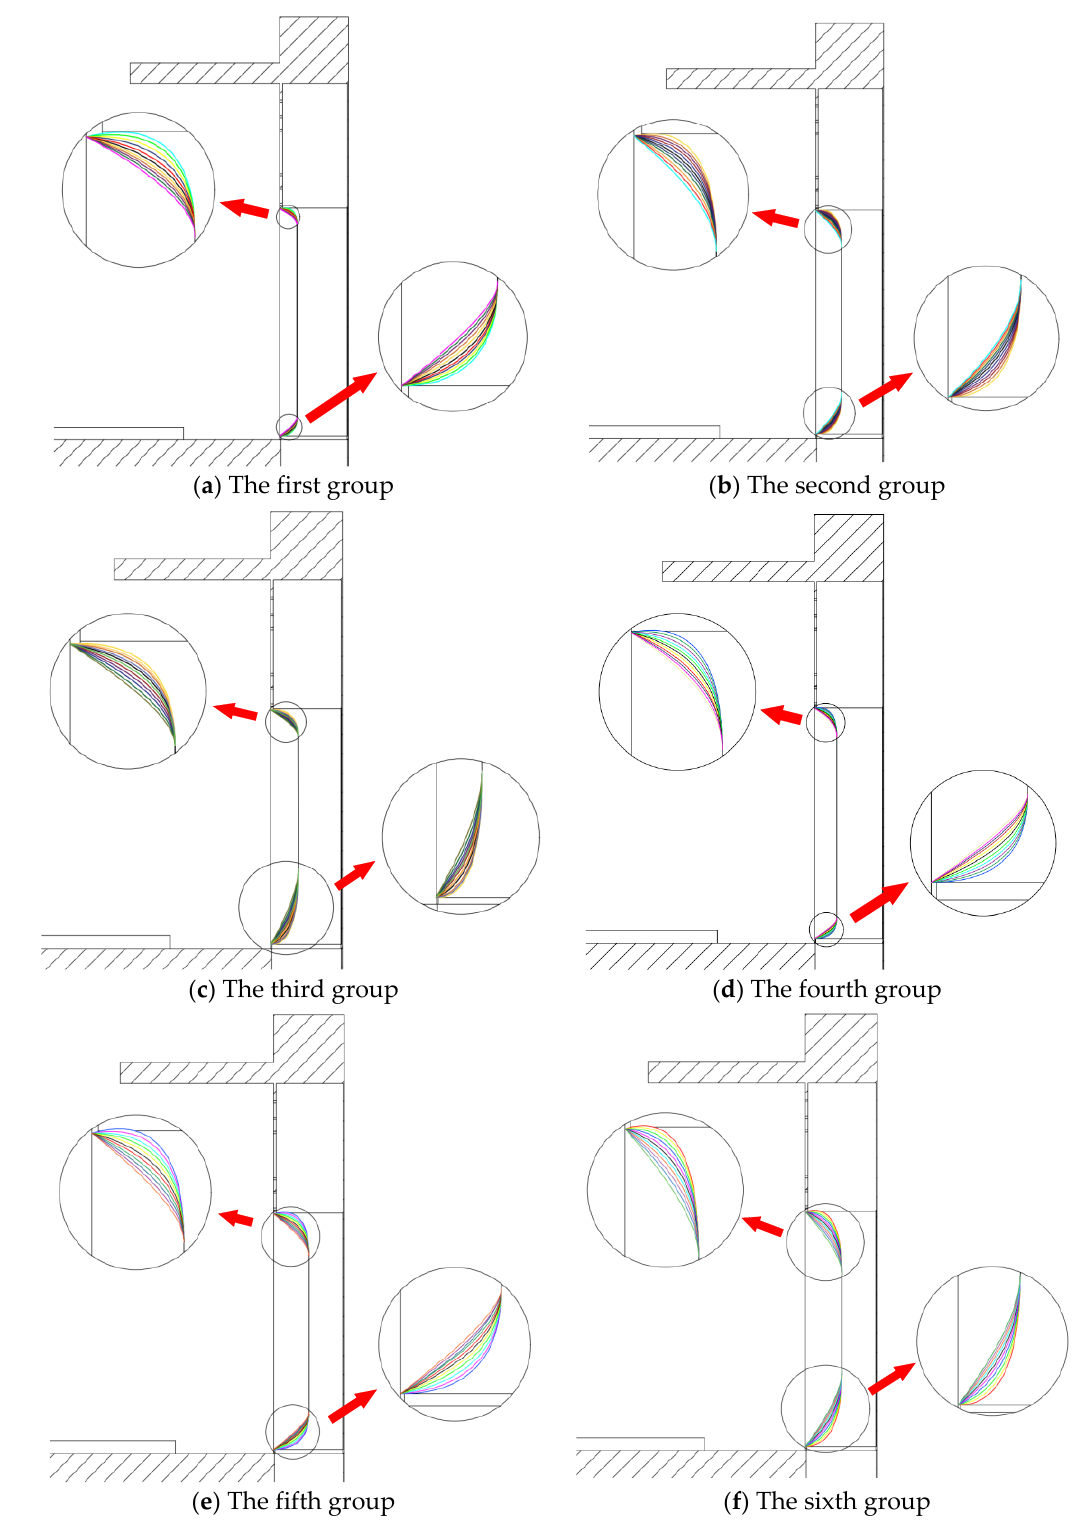
Figure 14. DOE initial samples.